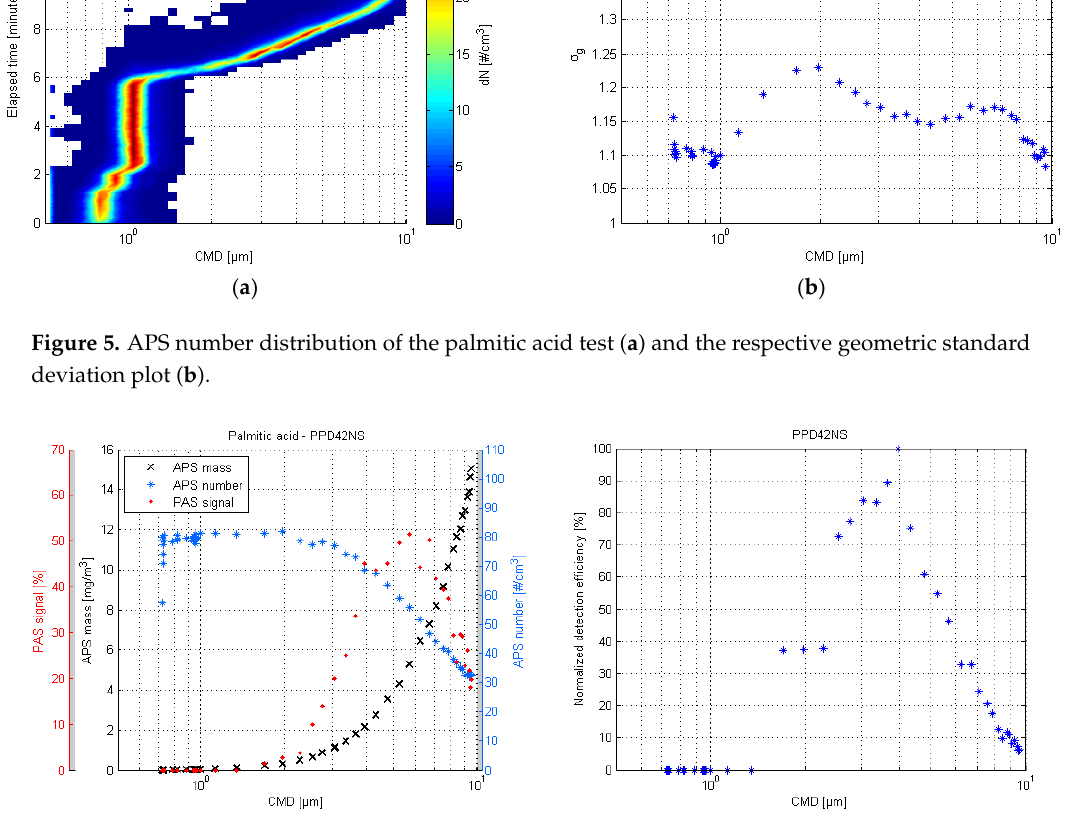
Figure 6. PPD42NS response plot of the palmitic acid test ( a ) and the respective normalized detection efficiency scatter plot ( b ).